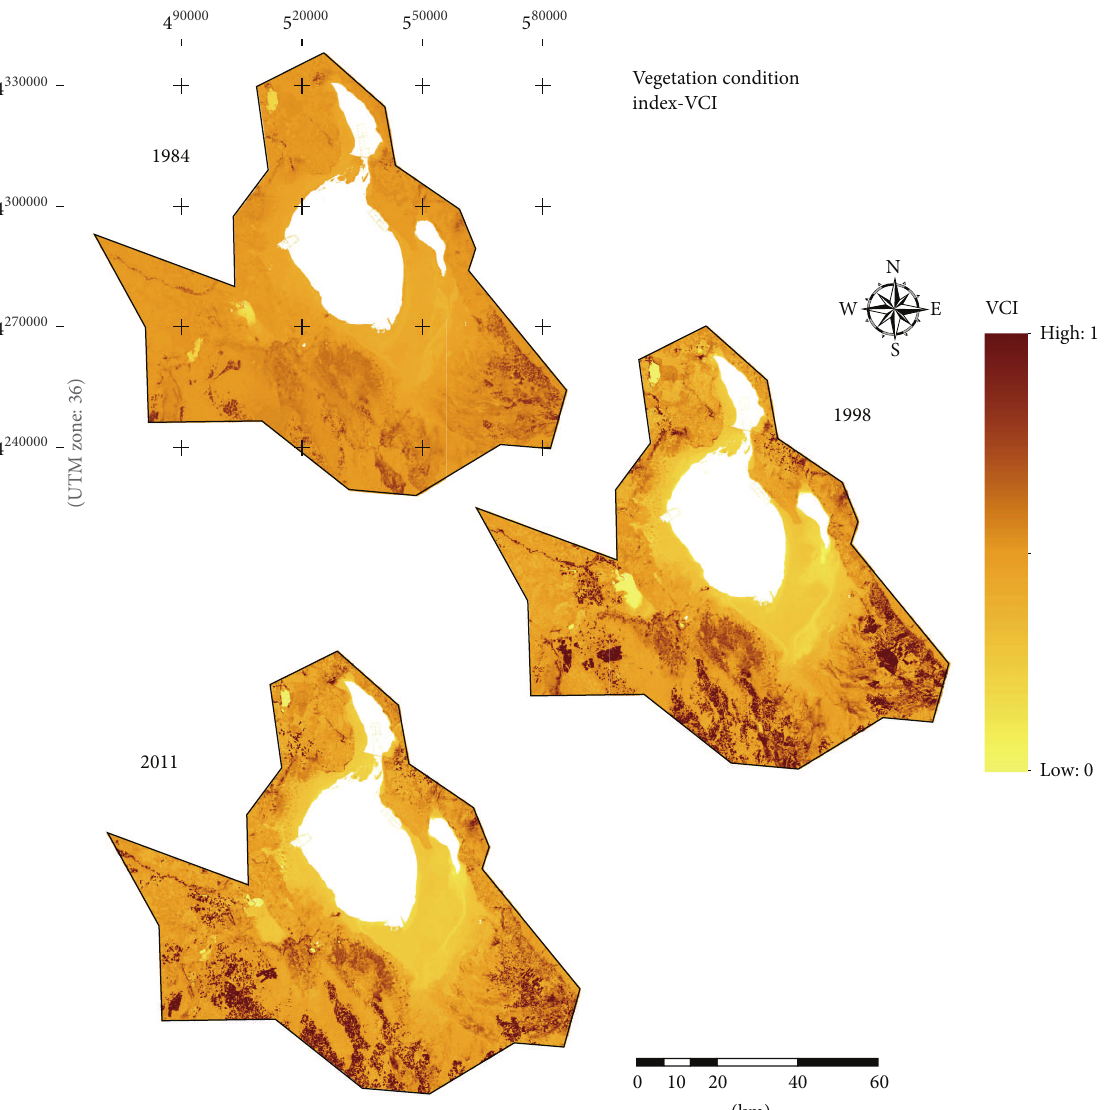
Figure 7: Multitemporal VCI indices maps for the